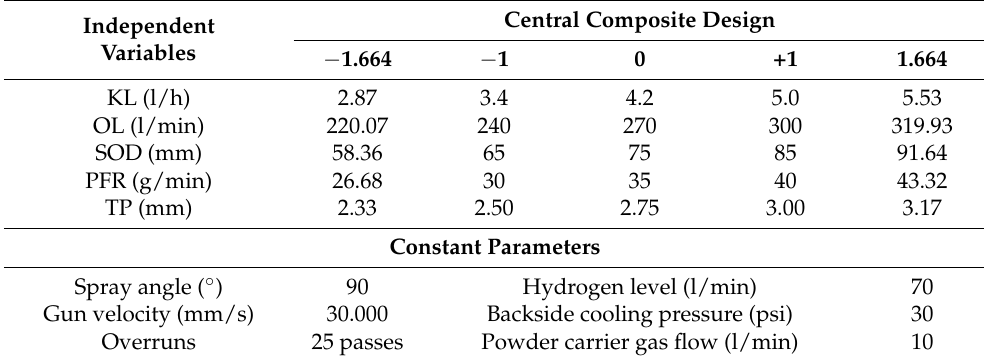
Table 1. Spray parameter settings used within this study.